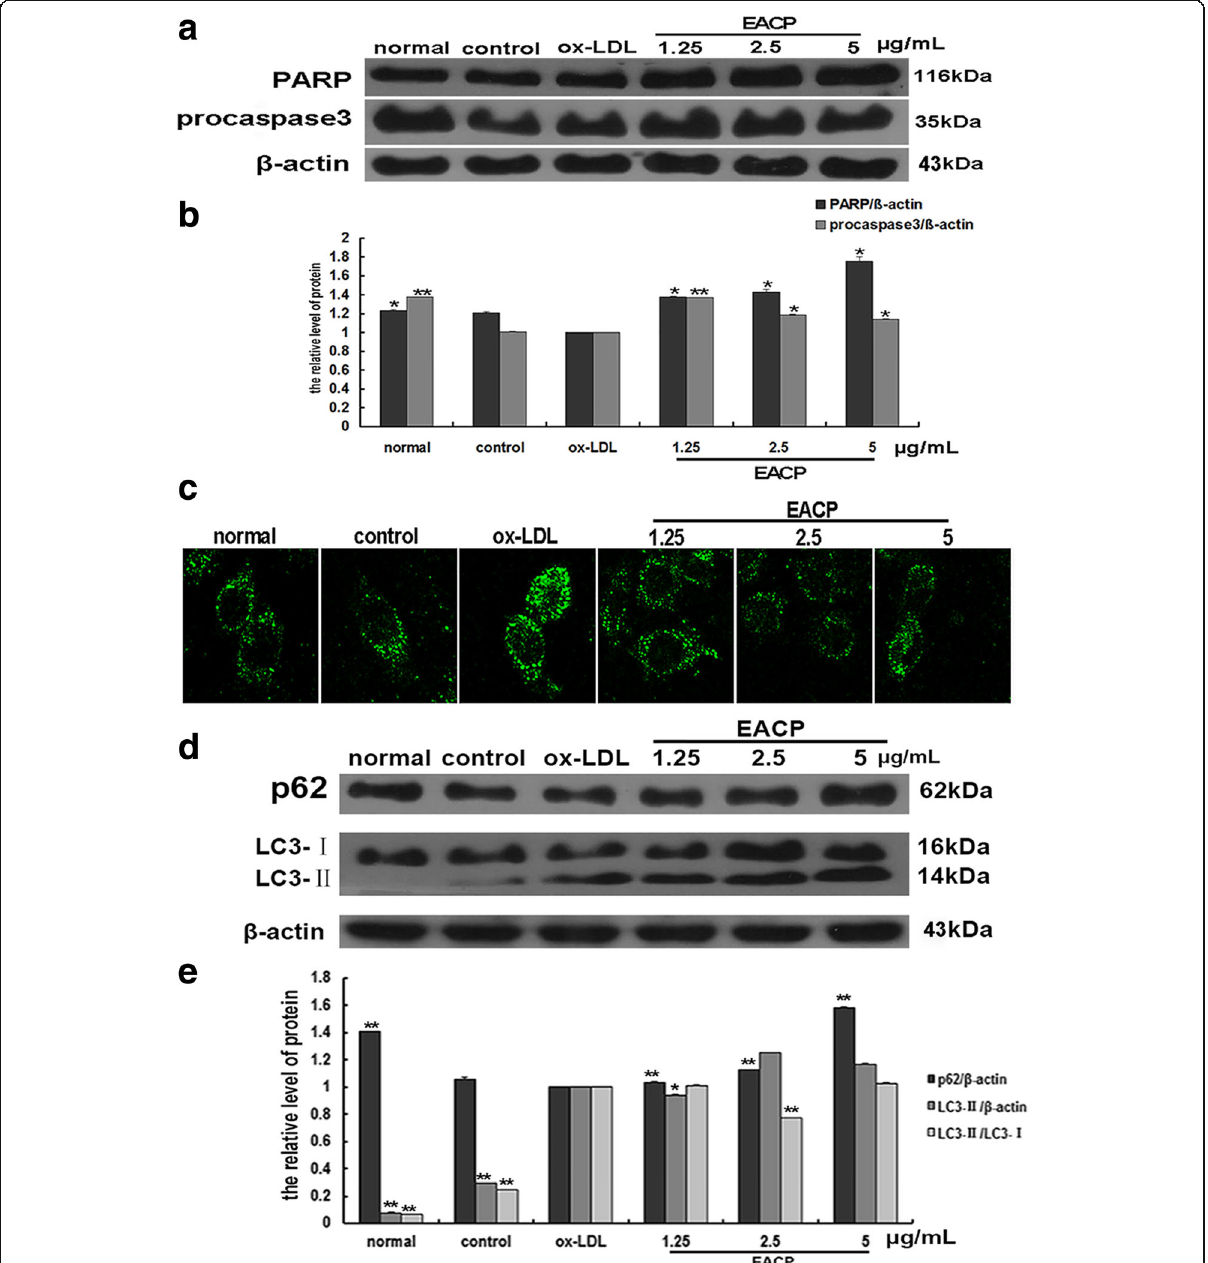
Fig. 3 EACP inhibited the levels of caspase 3, PARP cleavage, the ratio of LC3-II/LC3-I and enhanced the p62 level in ox-LDL induced HUVECs at 6 h. a , Expression of procaspase 3 and full length PARP after treatment with EACP in ox-LDL induced HUVECs; b , Quantification of relative expres- sion quantity in ox-LDL induced HUVECs at 6 h; c , Cells were stained with anti-LC3B antibody for immunostaining. Immunofluorescence graphs showed a decrease of endogenous punctuate LC3 after treatment with EACP; d , Expression of p62 and LC3B in ox-LDL induced HUVECs; e , Quantification of relative expression quantity in ox-LDL induced HUVECs at 6 h, respectively. ( * P < 0.05, ** P < 0.01 vs ox-LDL group, n = 3). Data are means ±